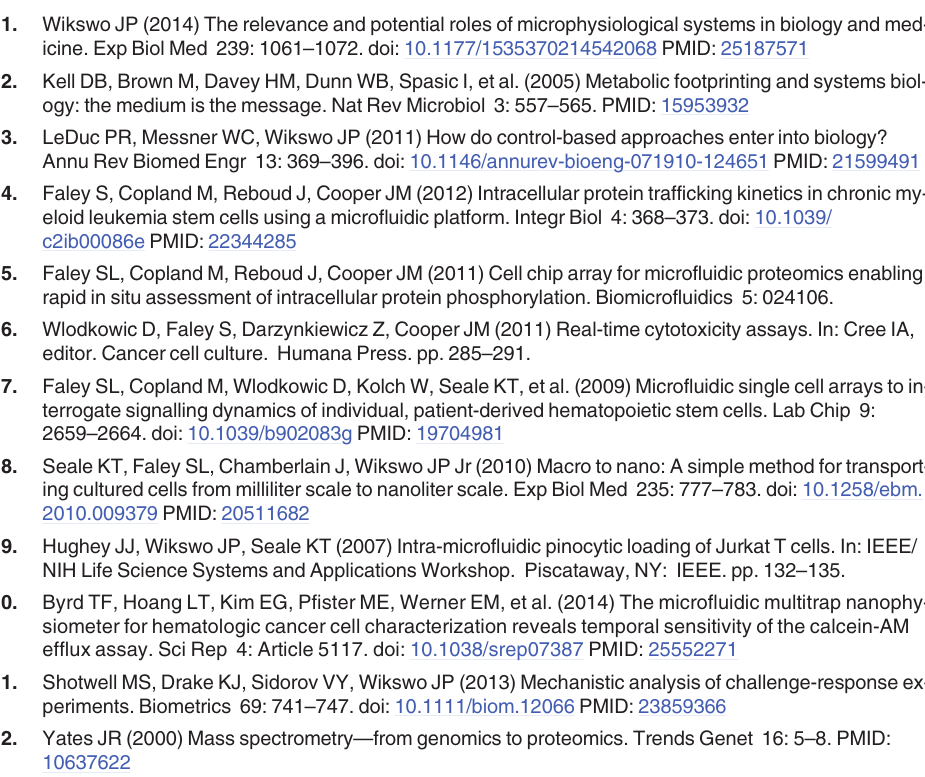
deposition (b (middle)), condensation of the silane into chains (b (bottom)), hydrogen bond formation between silanol and oxidized PDMS surface (c (left)), and covalent bond formation between silane and PDMS surface (c (right)) complete the silanization process. S2 Fig. Reduction of nonspecific adsorption by PDMS silanization. PDMS channels were perfused with FITC-insulin for 30 minutes (green), followed by 30 minutes of rinsing with Ringer ’ s solution (pink). The top three fluorescent images show the surface-bound insulin at 1 minute, 31 minute, and 60 minutes, with the bottom three images corresponding to the sur- face-modified channels. Silanized PDMS channels (blue line) retain (at maximum) only 25% of the total insulin retained by untreated PDMS (red